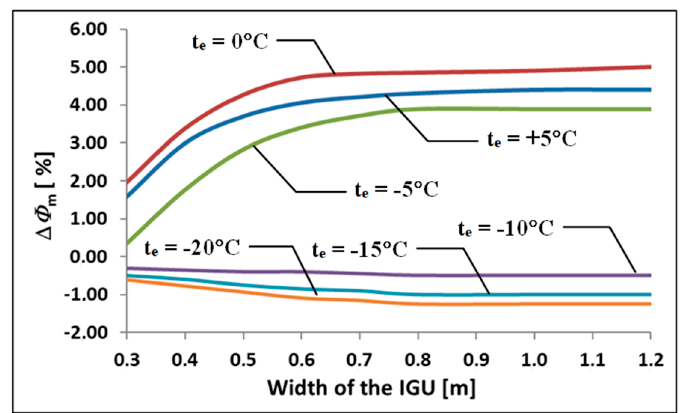
Figure 6. Dependence of the ∆ Φ m index on the width of the IGU and the outside temperature.